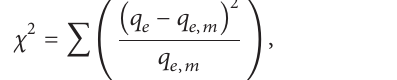
F 6: (a) Langmuir isotherm plots for the biosorption of Ni(II) T. viride biomass at different temperatures. (b) Freundlich isotherm plots for the biosorption of Ni(II) T. viride biomass at different